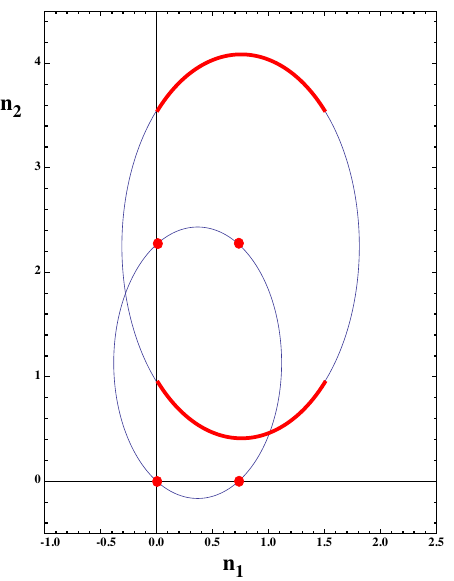
p p 10 ; (cid:6) 3 = 10)